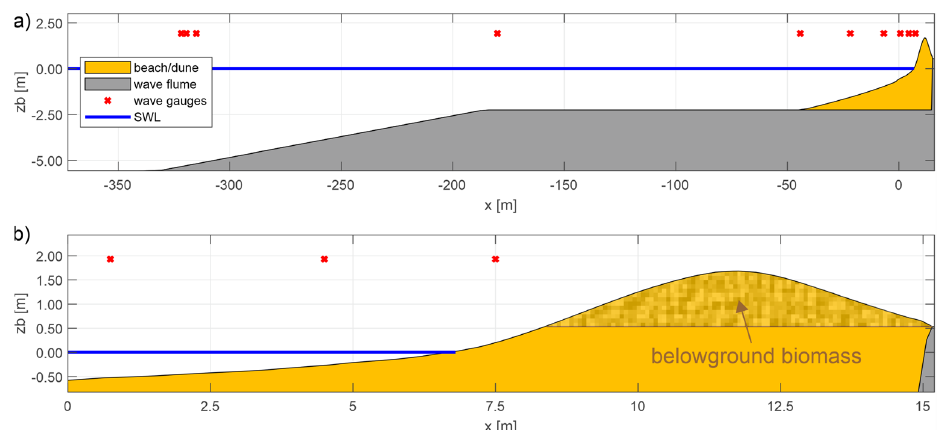
Figure 2. ( a ) The upscaled model setup including the beach-dune model, wave gauge stations and initial water level (S-conditions). ( b ) A zoom of the dune area and the section including belowground biomass, which is designated as the area above the concrete wall ( zb ≥ 0.54 m). The area between 0 < x < 16 m corresponds to the area where profile measurements were available. Table 1. Upscaled (hydrodynamic) boundary conditions according to Froude with still water level above the flume ground (SWL), zero-moment wave height H m 0 , peak wave period T p and the number and durations of wave bursts. The latter two define the applied simulation times ( tstop